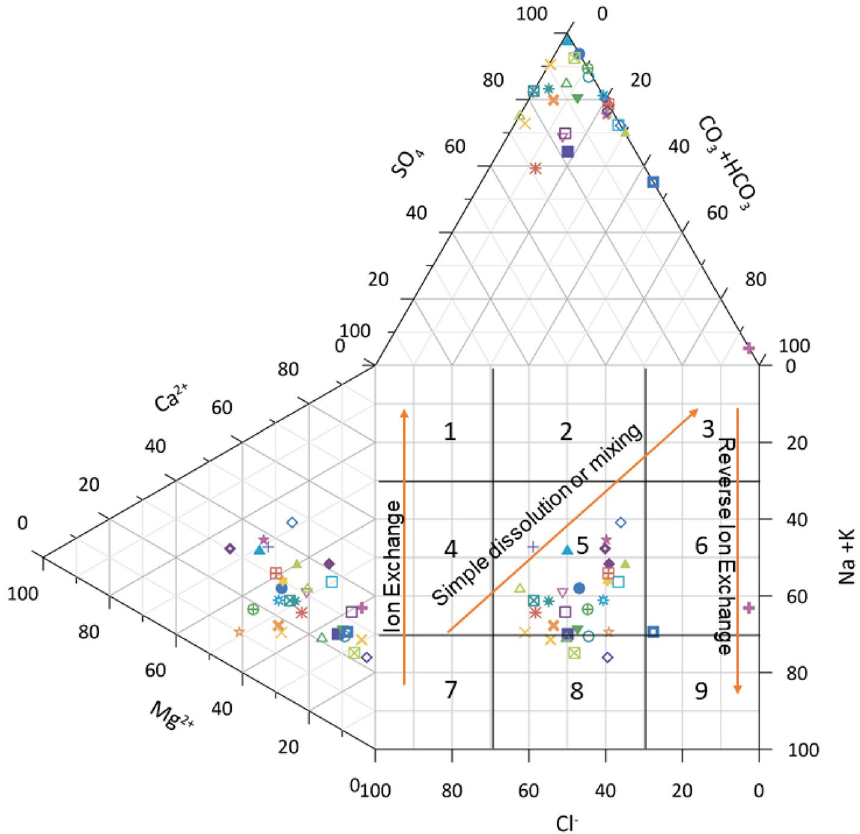
Figure 8. Durov plot illustrating hydrochemical processes involved in surface water/groundwater in different locations of Tawang area.